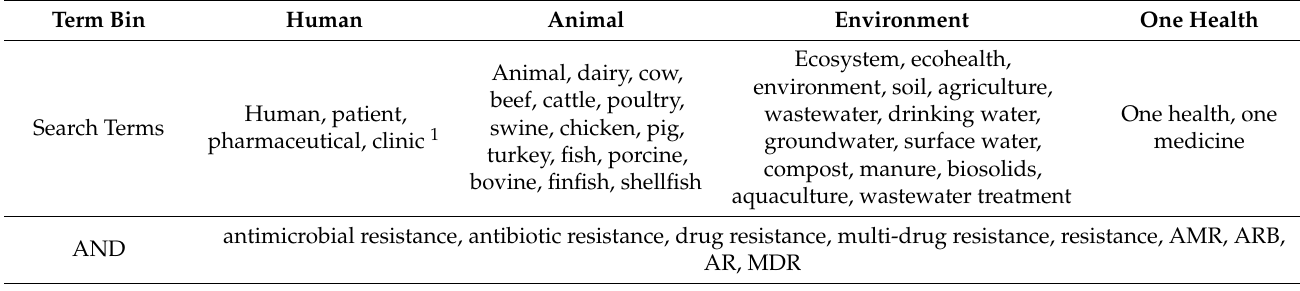
Table 1. Specific search key terms binned by One Health domains used to query and return articles from ContentMine containing the key terms in the title or abstract, with at least one word from the ‘AND’ row in the article’s title or abstract and not articles returned with words from the ‘NOT’